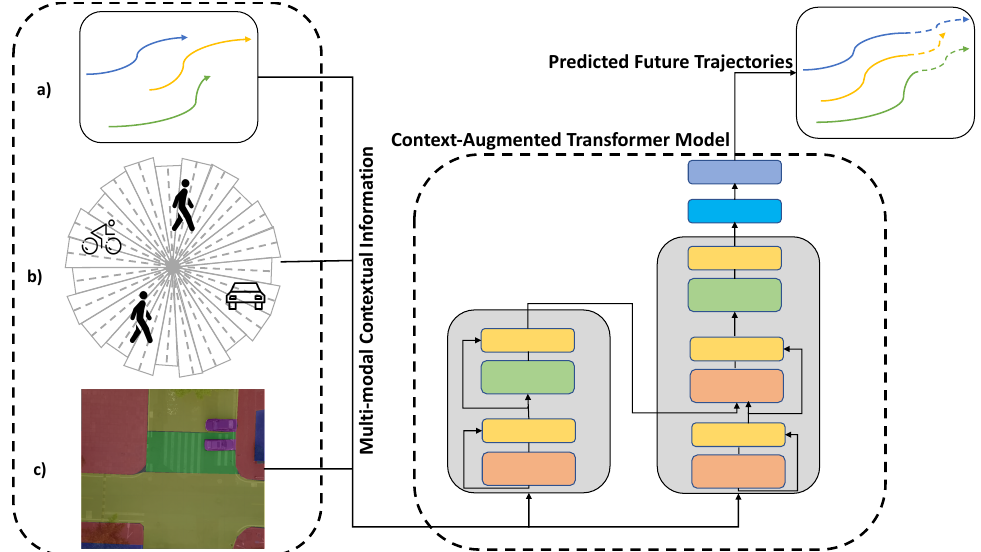
Figure 1. Our proposed context-augmented transformer framework for pedestrians’ trajectory pre- diction. The input is a multimodal contextual information: ( a ) past observed positional information, ( b ) agent interactions information and ( c ) scene semantics information. The output from our frame- work is the future positional information of all pedestrians in the